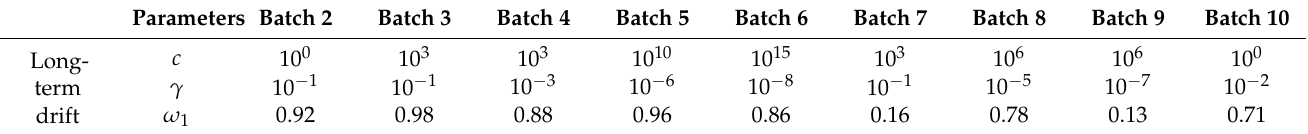
Table 3. Long-term drift parameter